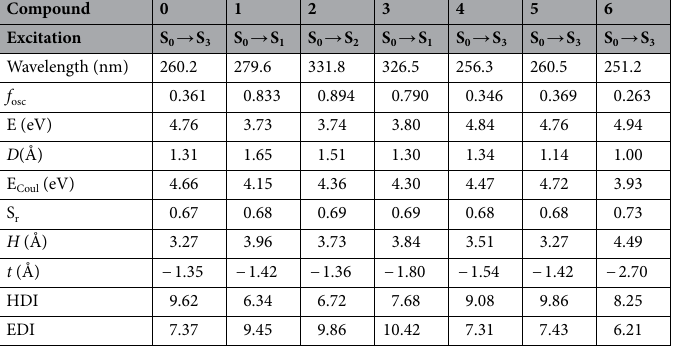
Table 6. Hole-electron analysis indices for the excitations with second highest f osc of compounds 0 and 1 – 6 .